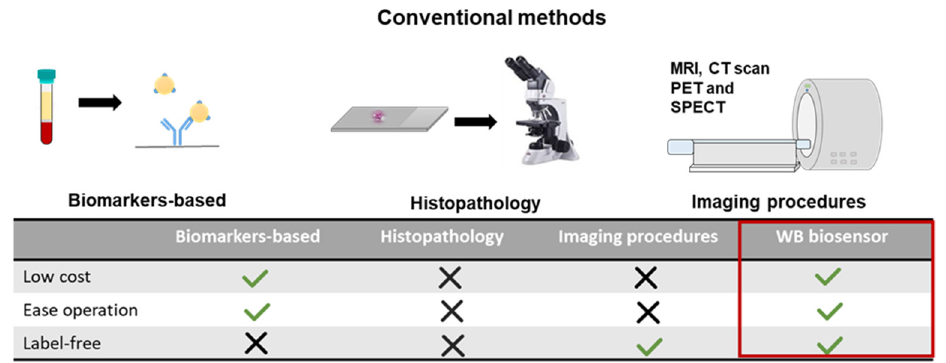
Figure 5. Advantages of the WB biosensor for metastatic detection. (Above) Schematics of conven- tional methods for metastatic detection. (Below) The low-cost, label-free, and ease of operation for the WB biosensor will promote widespread utility compared to techniques including biomarkers- based assays, histopathology, and imaging [22,35,47–49]. MRI = magnetic resonance imaging; CT = computed tomography scan; PET = positron emission tomography; SPECT = single-photon emission computer tomography.